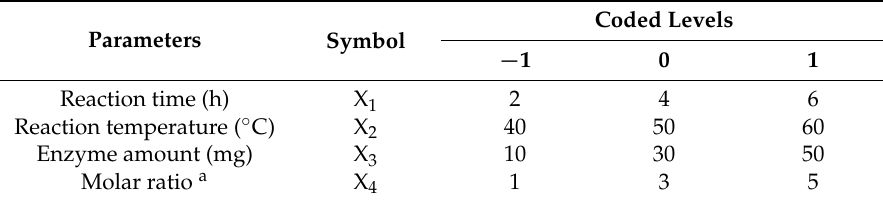
Table 4. Coding of experimental parameters and related